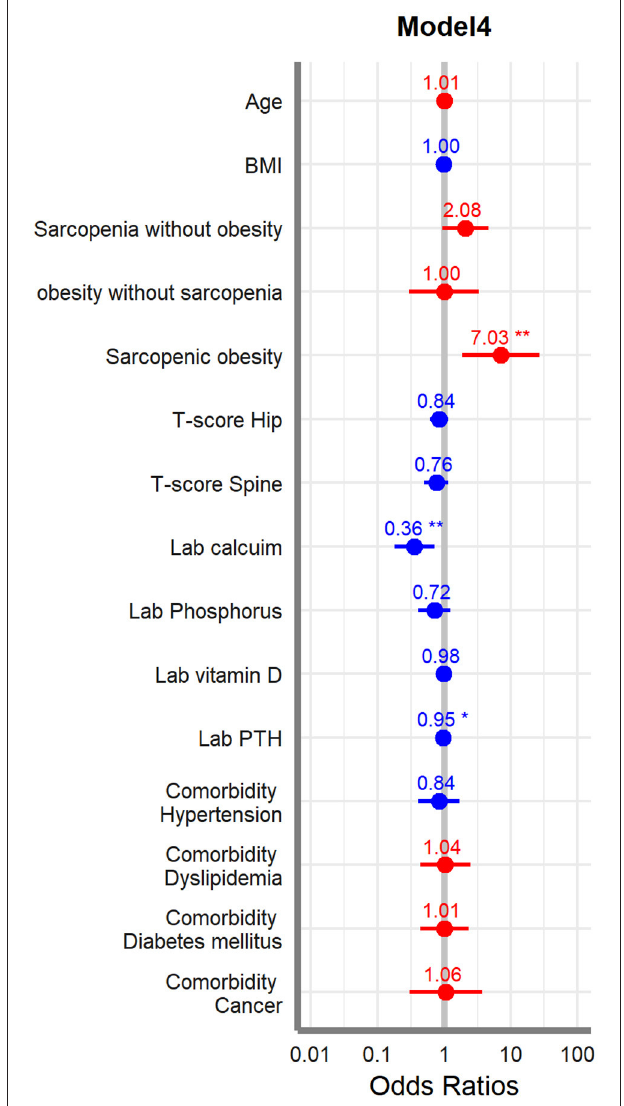
FIGURE 2 | Forest plot of multivariate regression analysis